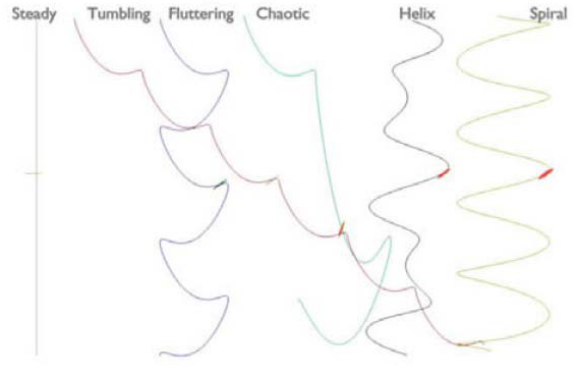
Figure 11. The Primitive motions of falling leaves of (Li,